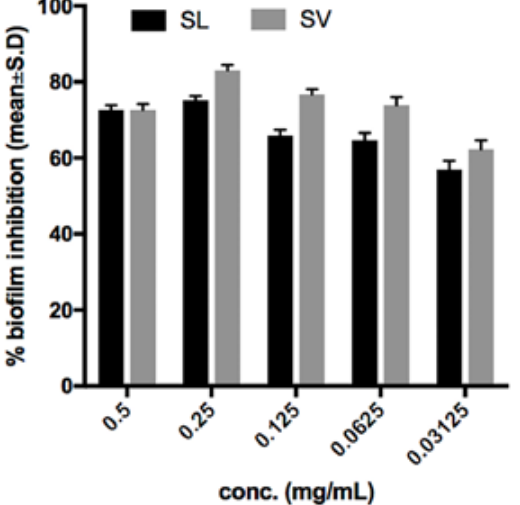
FIGURE 4 - The percentage of biofilm inhibition of C. albicans ATCC 90028 by Sternbergia spp.